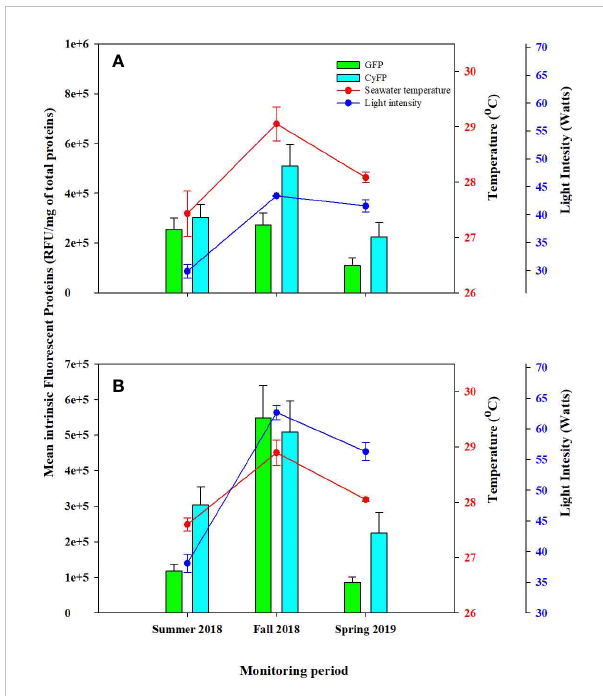
FIGURE 4 Comparison between Green Fluorescent (GFP), and Cyan Fluorescent Proteins (CyFP) concentrations from experimental colonies across survey periods. (A) Experimental colonies from deep waters farms (SD) and (B) experimental colonies from shallow waters farms (DS). Red and blue dots represent water temperature and light intensity respectively; Green bars represent GFP, and Cyan bars represent CyFP. Whiskers represent standard